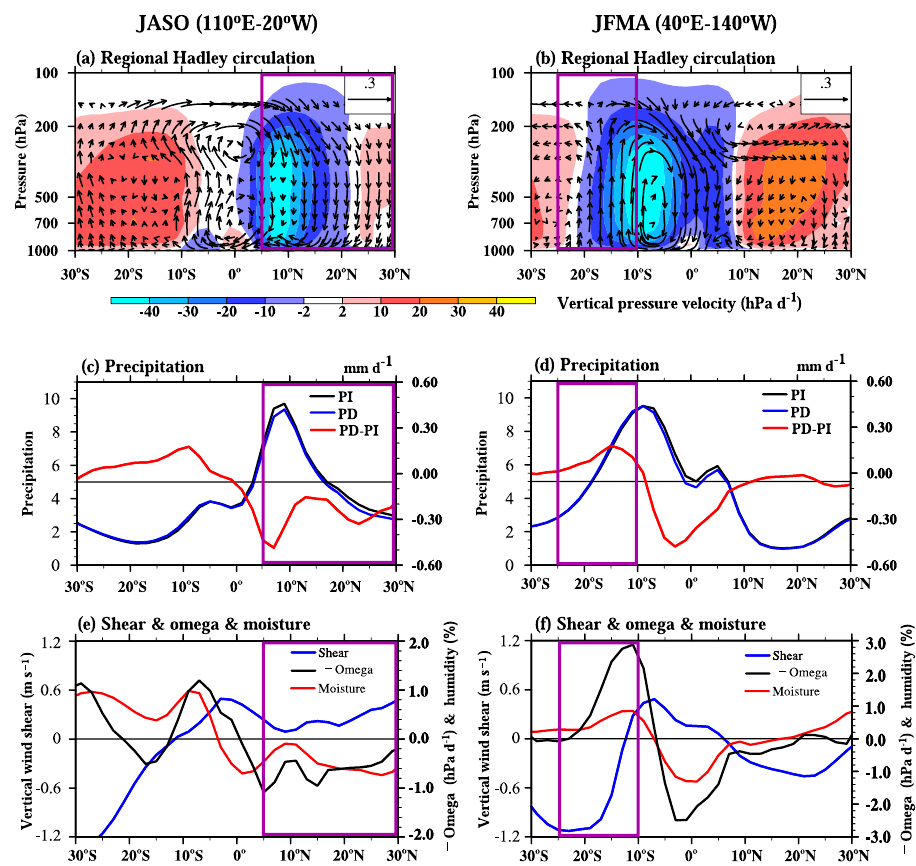
Fig. 4 Anthropogenic aerosol-induced zonal mean responses in tropical cyclone (TC) seasons. The left and right panels show the zonal mean over 110°E – 20°W during the Northern Hemisphere TC season (July-October, JASO) and 40°E – 140°W during the Southern Hemisphere TC season (January – April, JFMA), respectively. a , b Climatological mean meridional circulation (regional Hadley circulation) and its changes. The shading indicates climatological vertical pressure velocity (hPa d − 1 ) for pre-Industry period (1850 – 1879), and the vector is the composite of zonal wind change (m s − 1 ) and 100 times of vertical velocity change (Pa s − 1 ). c , d precipitation (mm month − 1 ) for pre-Industrial period (PI, black), modern period (PD, blue), and their difference (PD-PI, red). e , f changes of vertical wind shear (blue, left y-axis, m s − 1 ), negative vertical pressure velocity (black, right y-axis, hPa d − 1 ), and 500 hPa relative humidity (red, right y-axis, %). The purple boxes mark the latitudinal extents of the TC formation